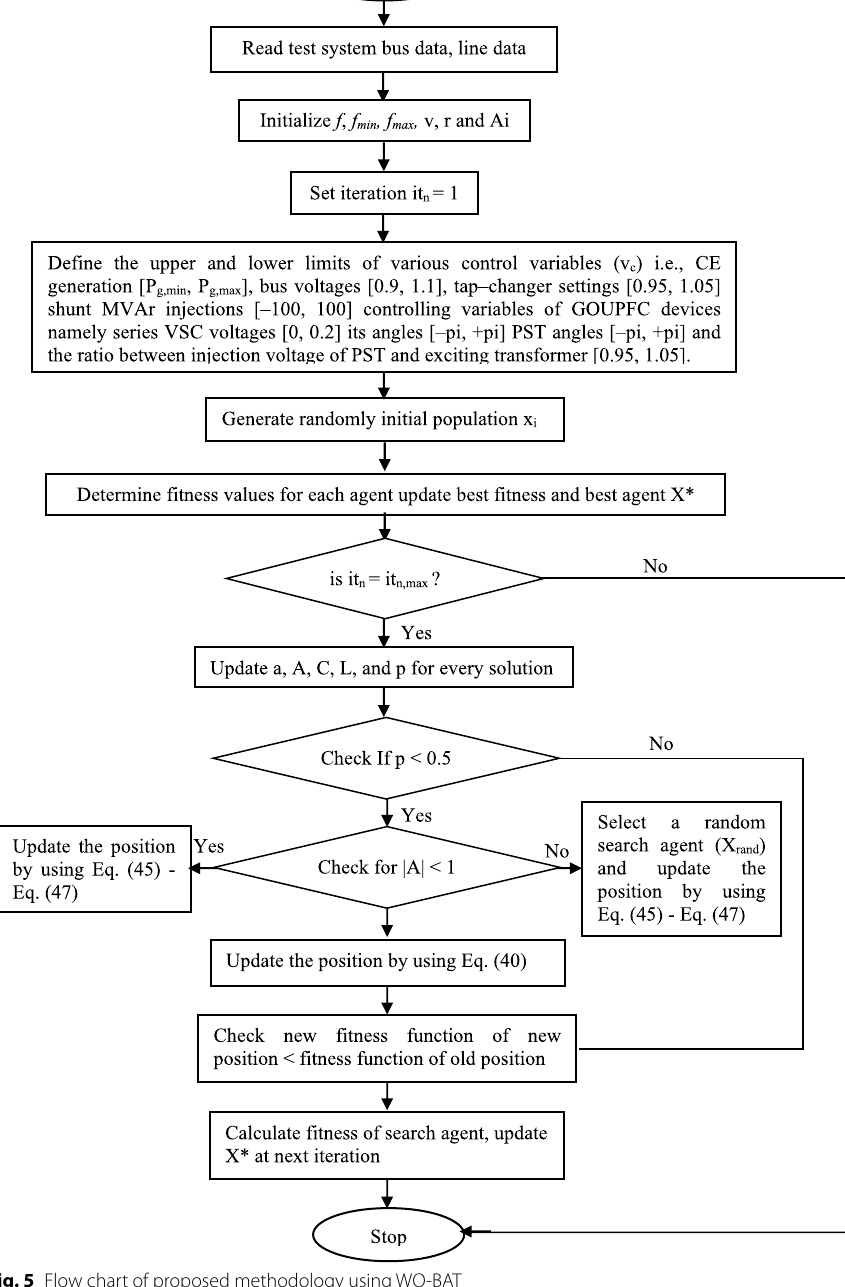
Fig. 5 Flow chart of proposed methodology using